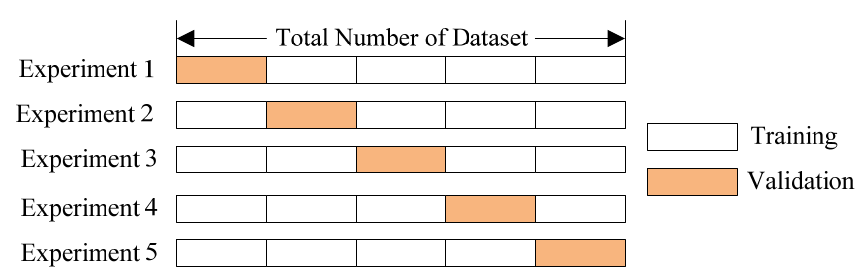
Figure 7. A 5-fold Cross Validation.